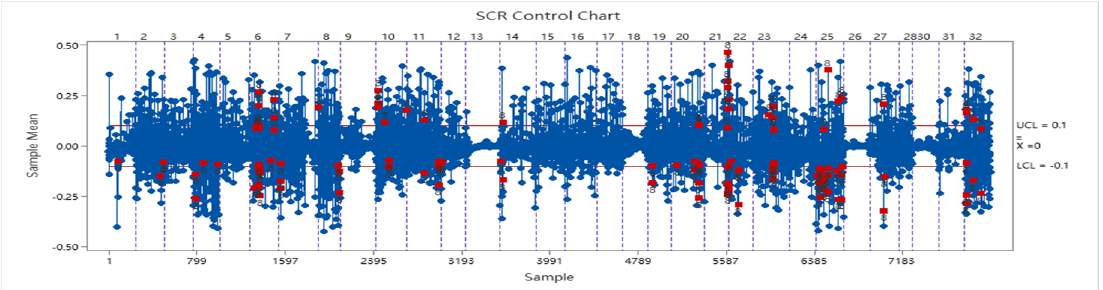
Figure 12. Shewhart control chart of skin conductance amplitude data.